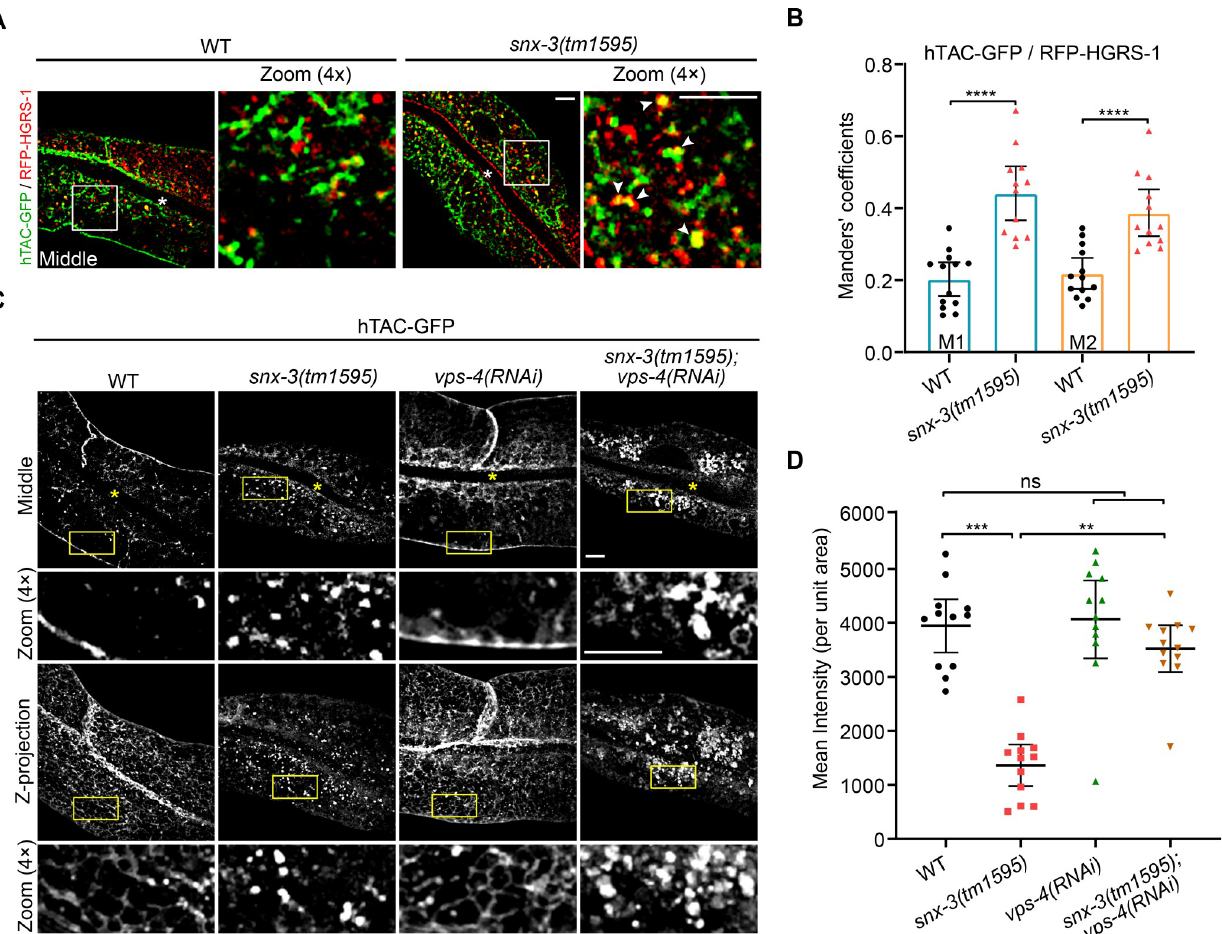
Fig 4. hTAC is captured by the ESCRT complex in snx-3(tm1595) mutants. (A) Confocal images showing the overlap of RFP-HGRS-1 with hTAC-GFP is increased in snx-3(tm1595) mutants. (B) Manders’ colocalization coefficients for hTAC-GFP and RFP-HGRS-1 as depicted in A were calculated, error bars are mean ± 95% CI (WT: [ROI] = 13, n = 9; snx-3(tm1595) : [ROI] = 12, n = 7). ���� P < 0.0001 (Student’s t test). M1: green pixels overlapping red; M2: red pixels overlapping green. (C) Confocal images showing the distribution of hTAC-GFP in intestines of snx-3(tm1595) mutant, vps-4 RNAi -treated and snx-3(tm1595); vps-4(RNAi) double mutant animals. hTAC-GFP accumulated into clusters of vacuoles in the intestine of snx-3(tm1595); vps-4(RNAi) double mutants. (D) The average FIs of hTAC-GFP depicted as Z-projection images in C were calculated. Error bars are mean ± 95% CI ([ROI] =